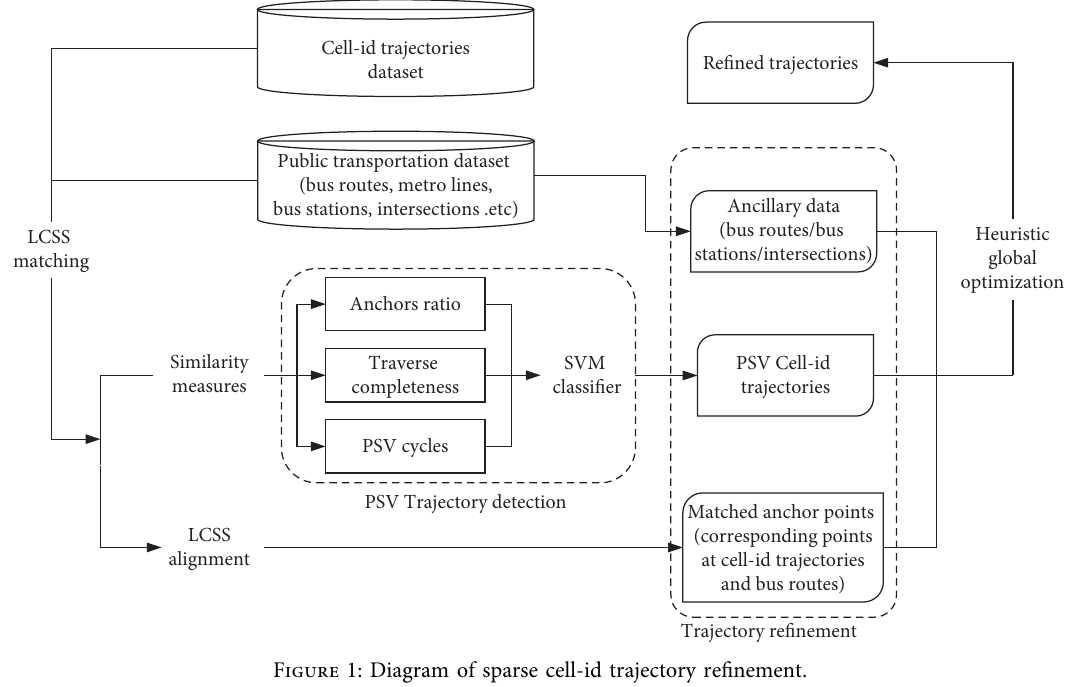
Figure 1: Diagram of sparse cell-id trajectory refinement.